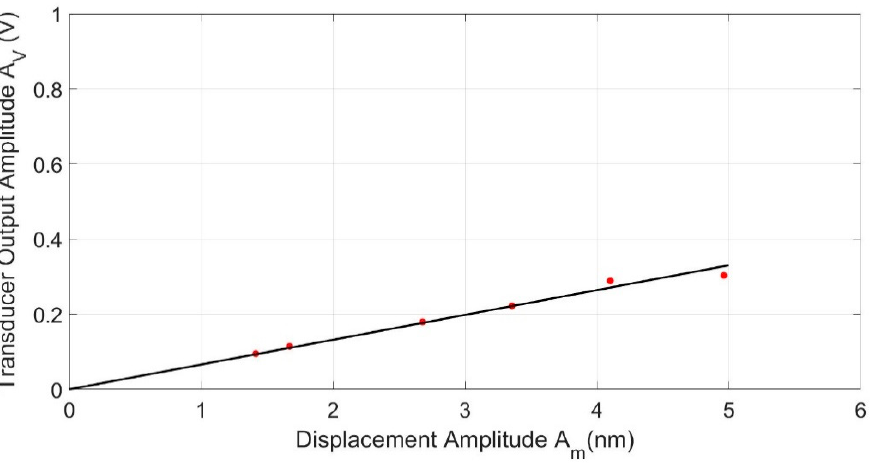
Figure 7. Voltage to meter conversion at ultrasonic incident amplitudes 70 V, 90 V, 140 V, 210 V, 280 V and 350 V.